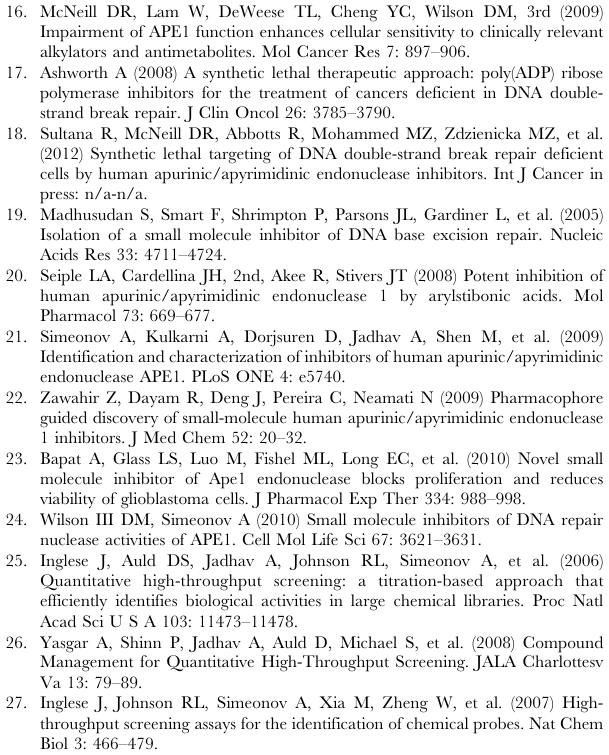
Figure S1 Repeat AP site testing of the three hits whose combination treatments produced large standard deviations Figure 8) upon initial testing. A decrease in the standard deviation was observed for these compounds upon repeat testing, with